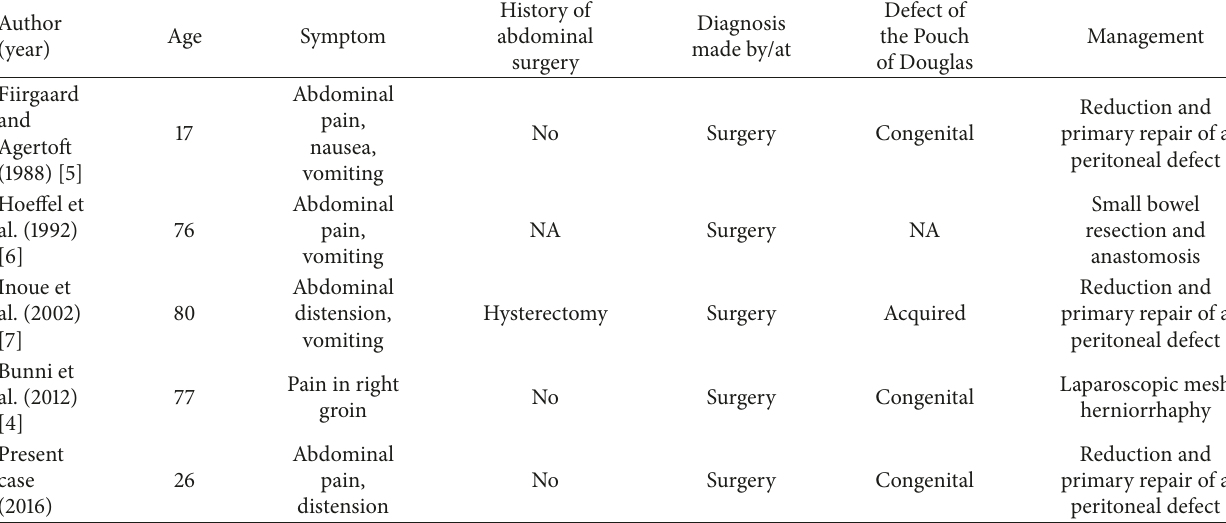
Table 1: Clinical features of internal hernia through a defect of the Pouch of Douglas in English